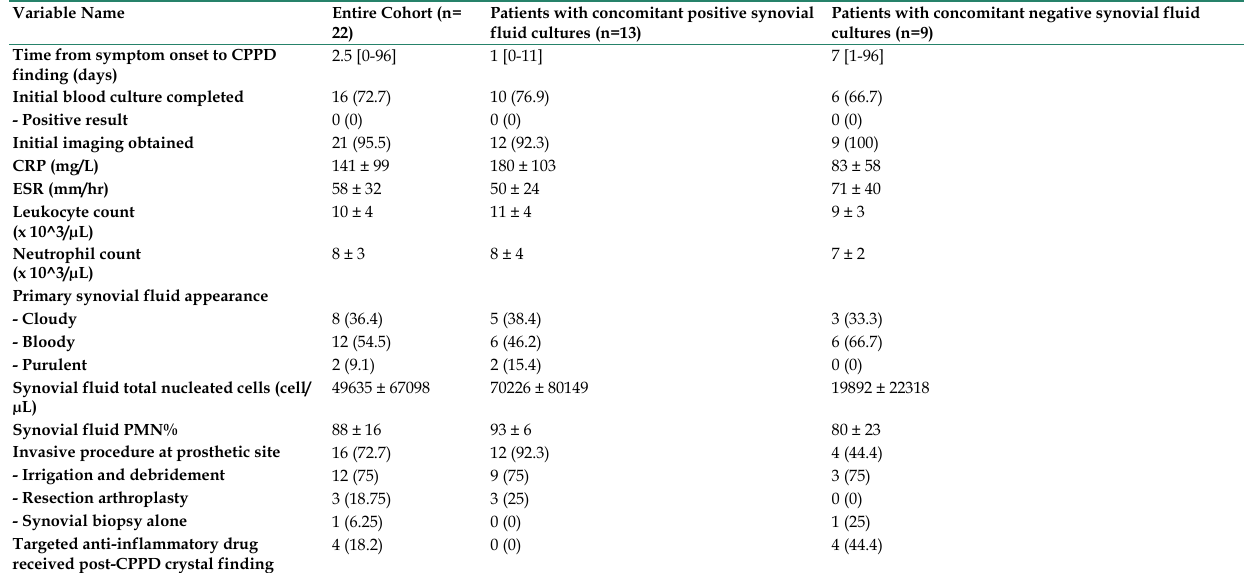
Table 3. Management of Patients with Prosthetic Joint and CPPD